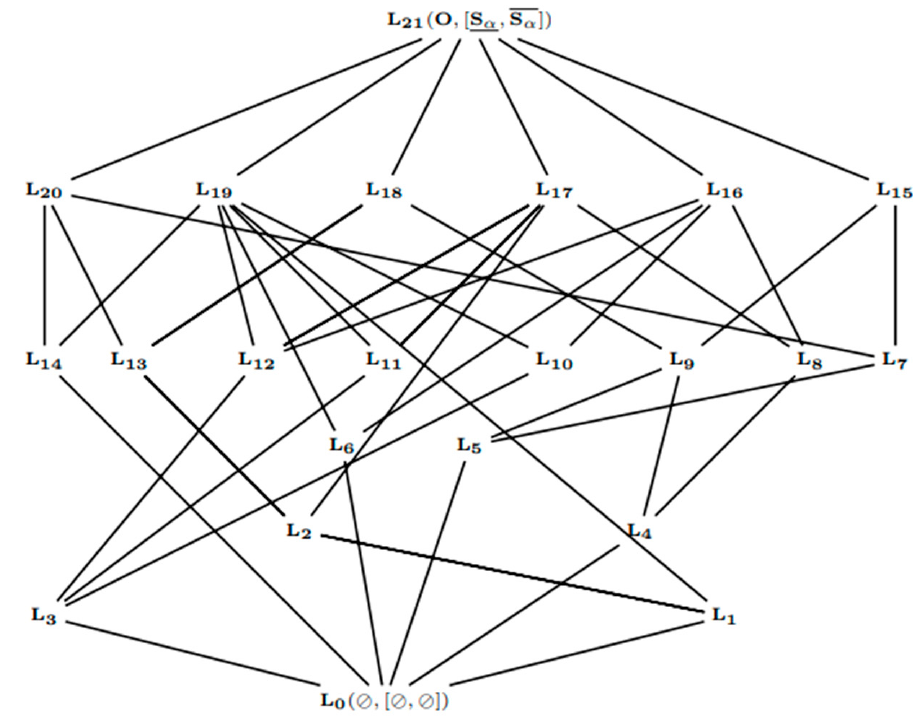
Figure 6. From Table S α